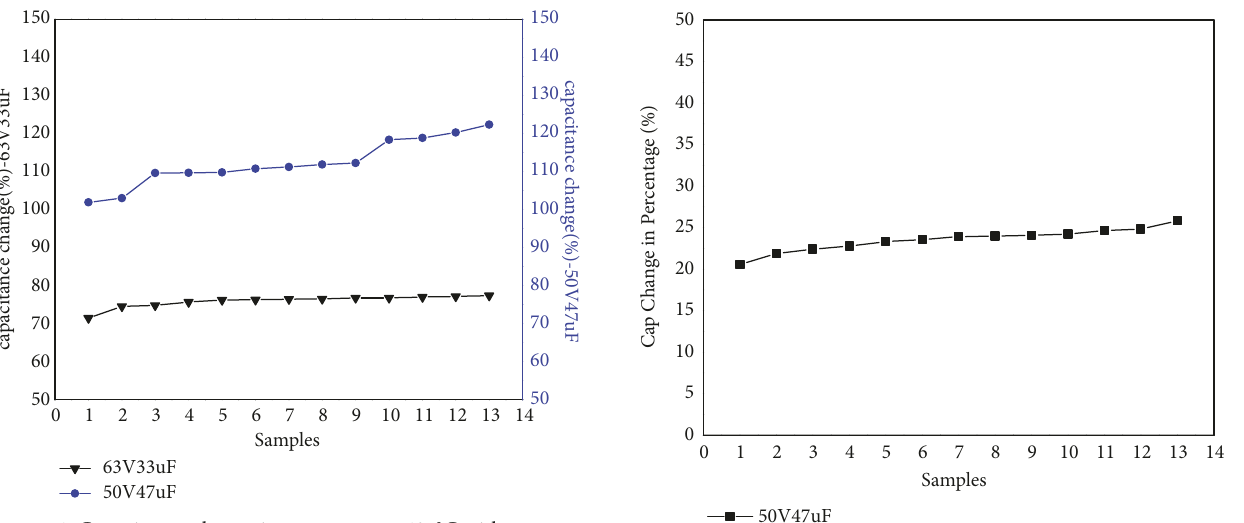
Figure3:Capacitancechangeof50V47 𝜇 Fat125 ∘ Cwithwaterwash